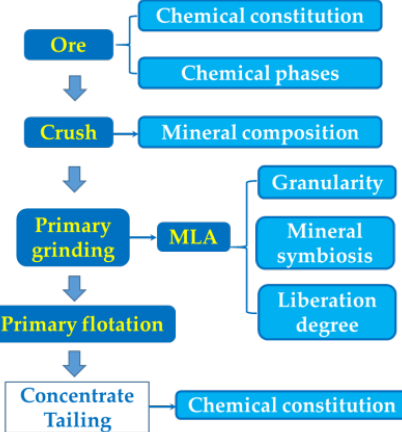
Figure 1. The technical route of the current investigation.